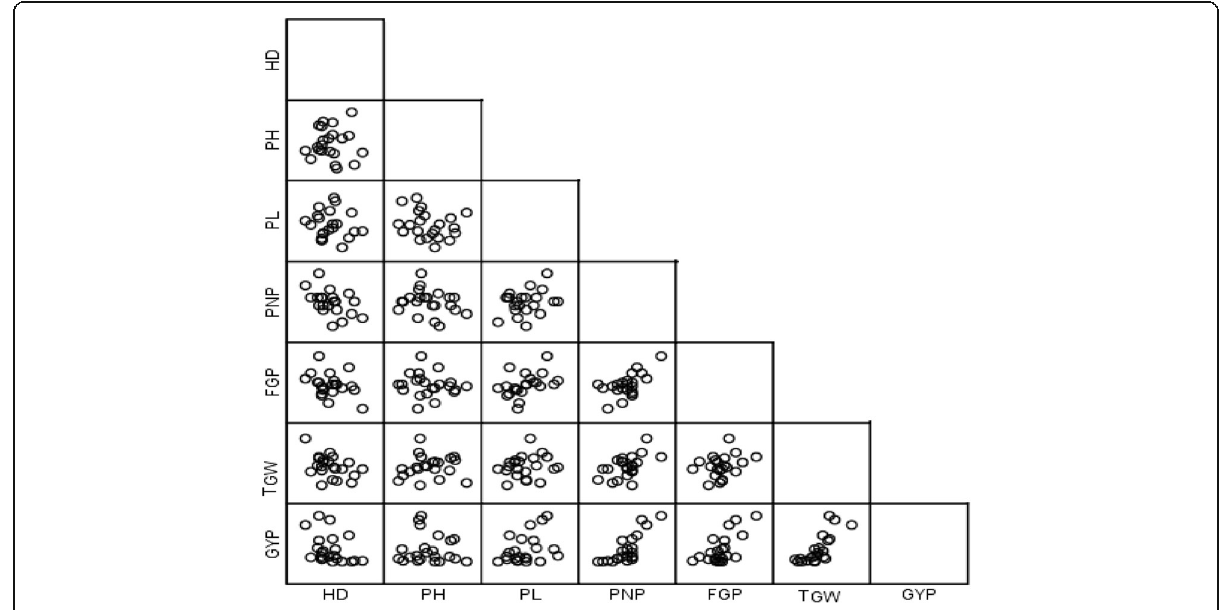
Fig. 1 Association between grain yield and its components characters in 22 Egyptian and exotic rice genotypes